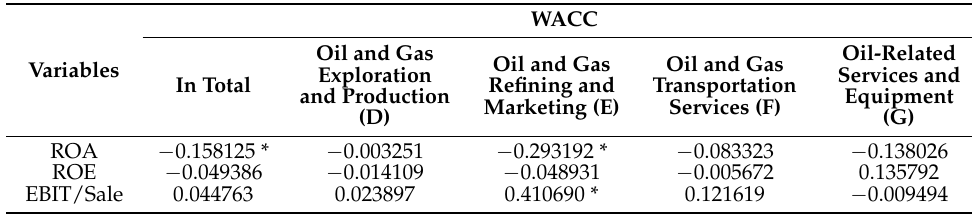
Table 9. Summary statistics correlation matrix for WACC and intra-industry activity division.